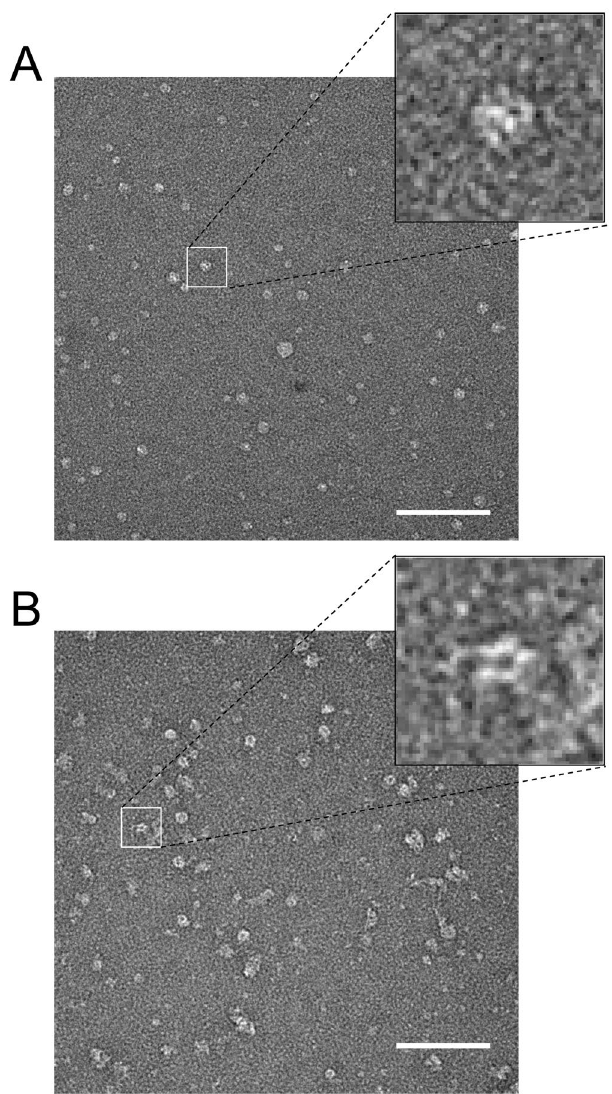
Figure 2. Effect of detergent on the 3xflag-LRRK2 structure. Negative stain TEM images of LRRK2 eluted using in 20 mM Tris/HCl pH 7.4, 200 mM NaCl, 5 mM MgCl 2 , 1 mM DTT. ( A ) Without the addition of detergent; almost all of the particles have a globular appearance and structural details are not visible. ( B ) With 0.02% of Triton X-100; many of the particles have an elongated shape and some structural detail is evident. Dimeric sides-views are clearly visible (inset). However, there are also some globular particles demonstrating that even in the presence of detergent the protein is not completely stable when the Tris buffer is employed (see Materials and Methods and Fig. 4). Scale bars: 100 nm. Insets are 5 times